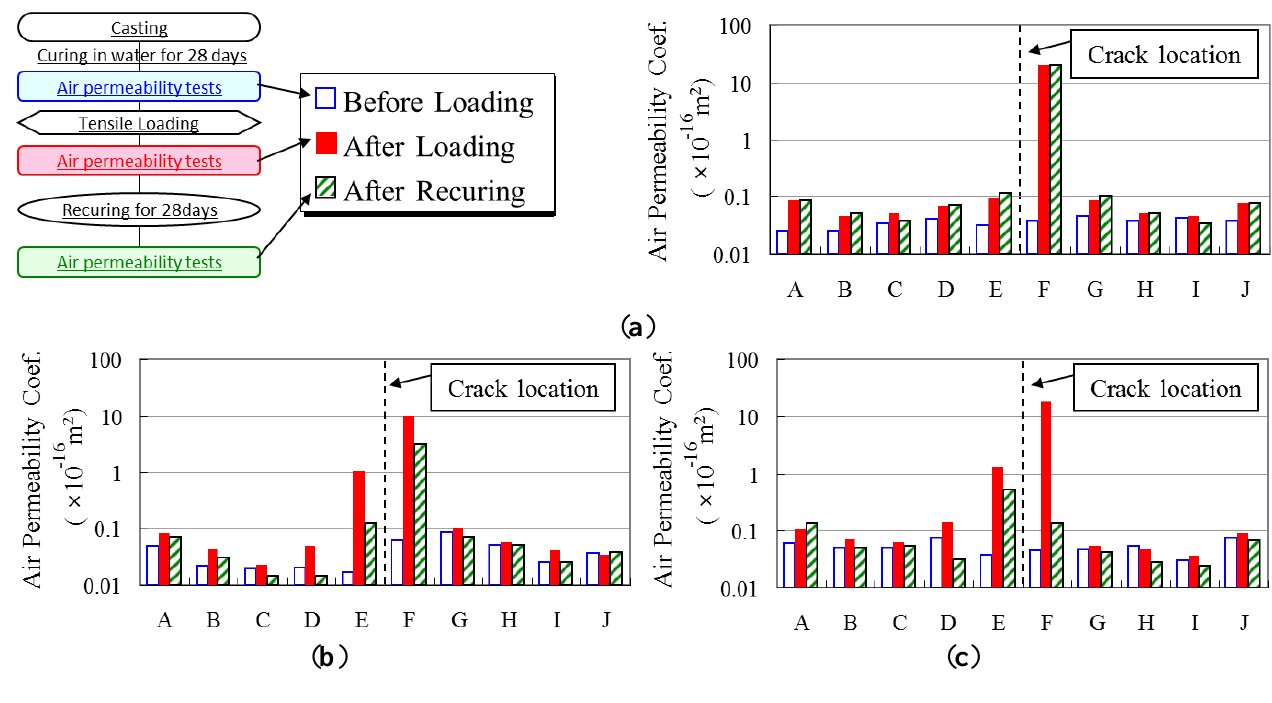
Figure 10. Fly ash concrete air permeability test results. ( a ) Recuring in air; ( b ) Recuring in water—Spceimen No.1; ( c ) Recuring in water—Specimen